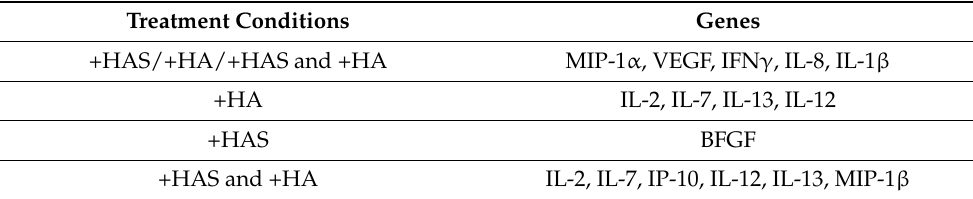
Table 3. List of genes with a differential correlation pattern after treatment